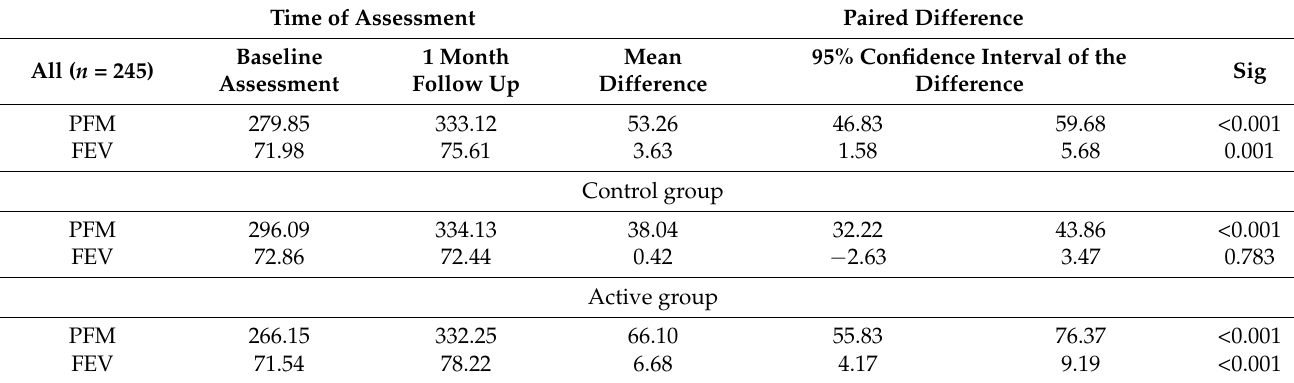
Table 9. Mean scores of inhaler technique for the peak flow meter (PFM) readings and forced expiratory volume (FEV) readings. Time of Assessment Paired Difference All ( n =